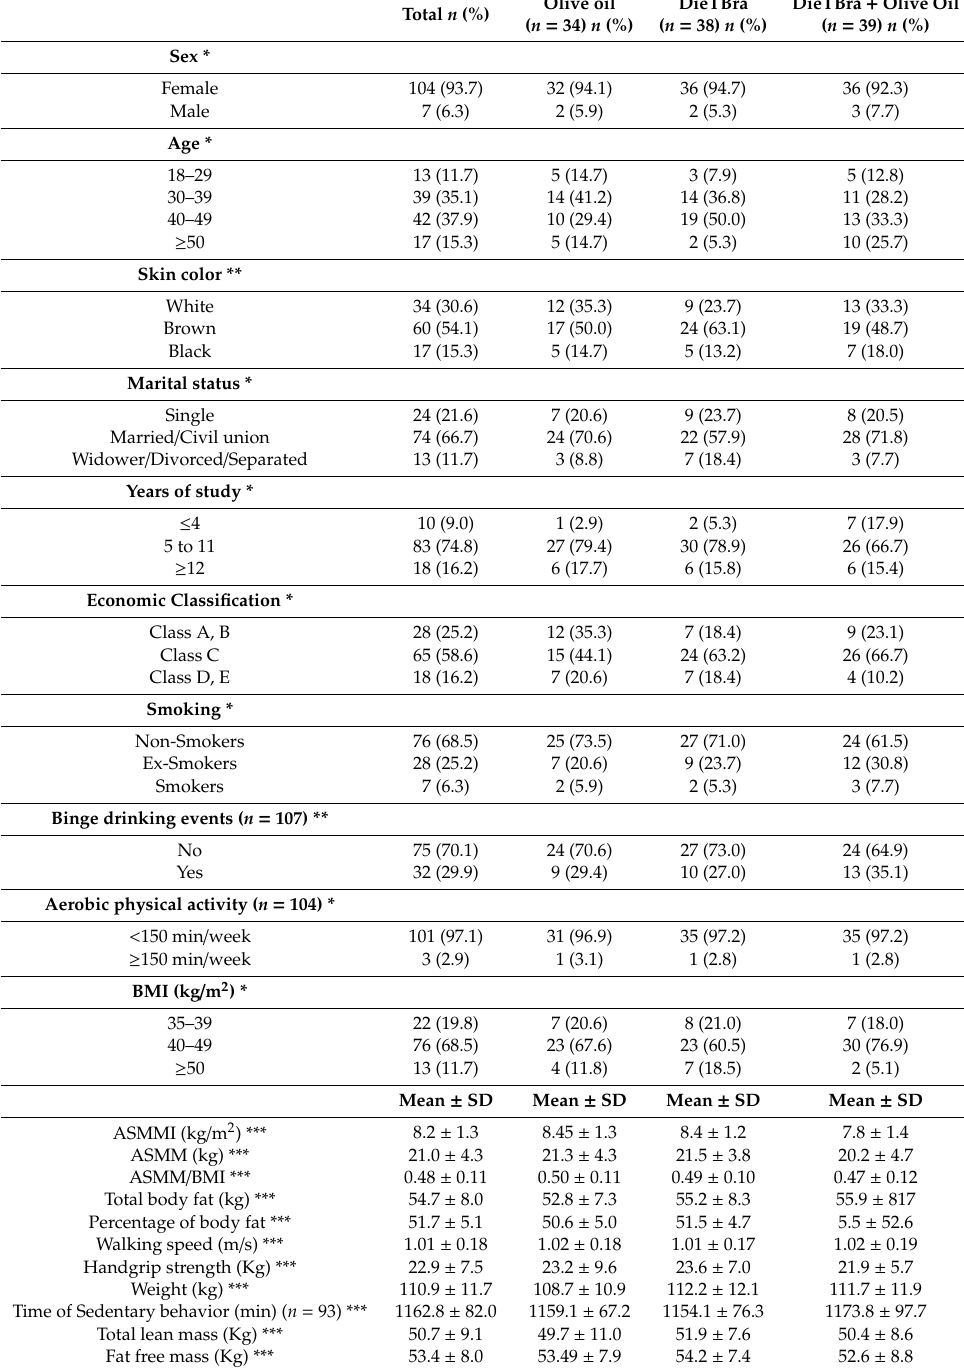
Table 1. Participants’ characteristics at baseline according to the three randomized intervention groups in adults with severe obesity, Brazil, 2016 ( n =